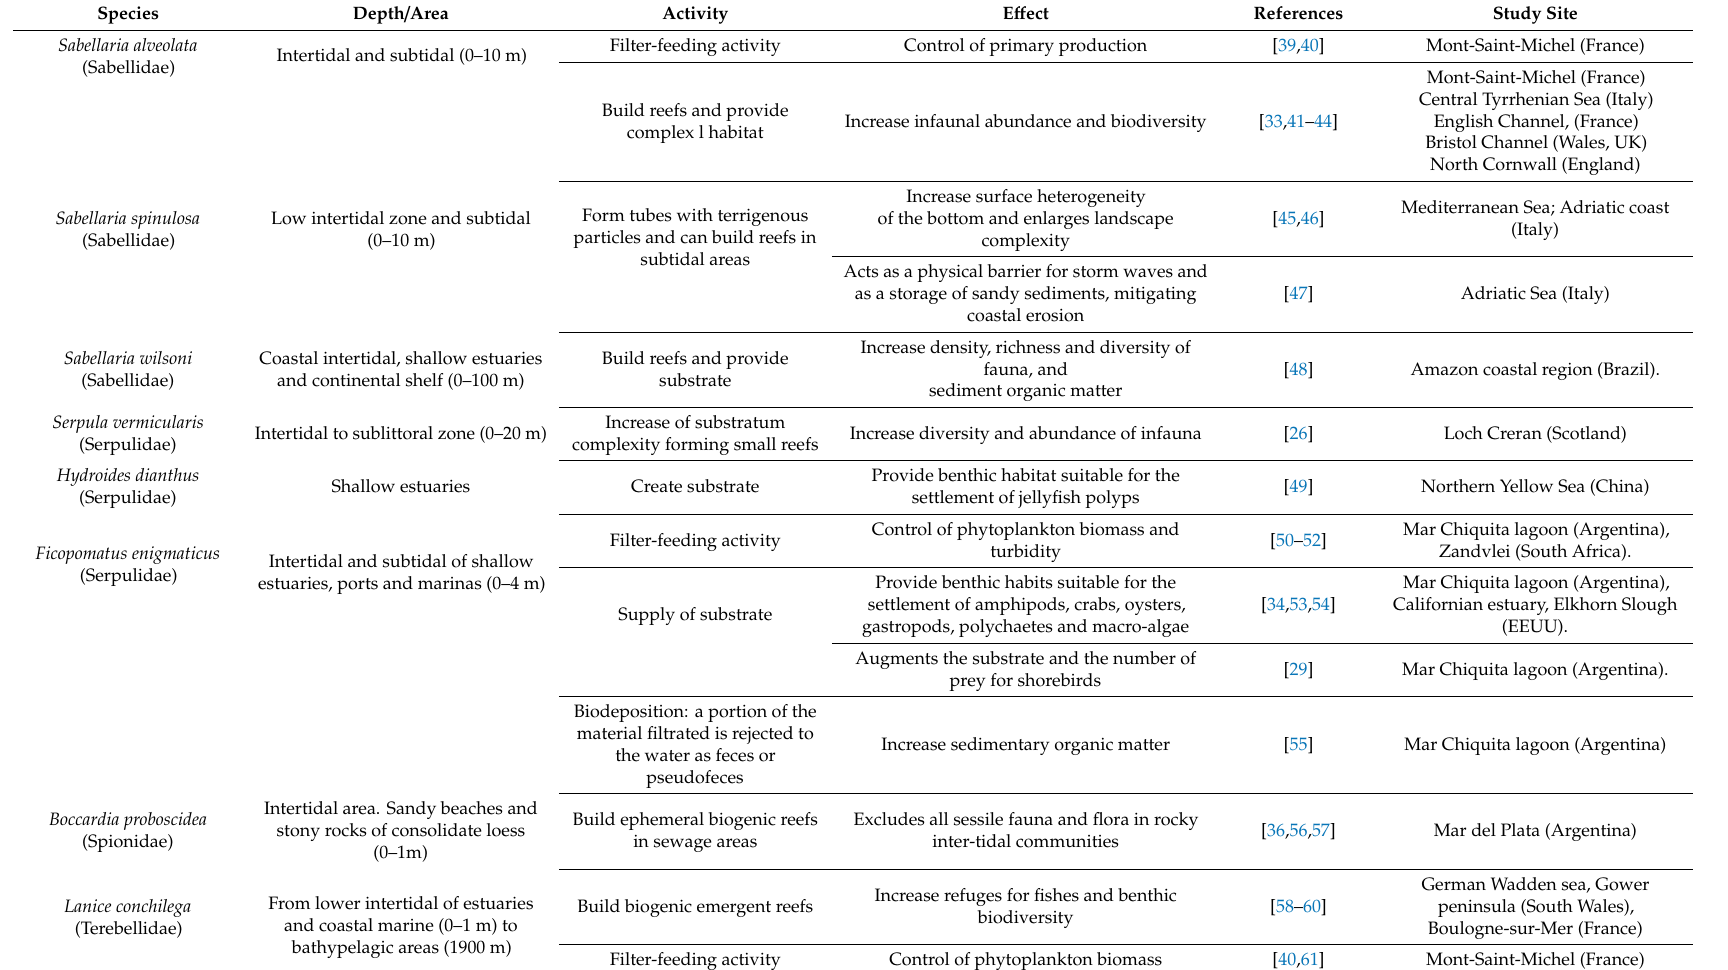
Table 1. Examples of reef-building, ecosystem engineering polychaetes and their e ff ect on structure and function of the